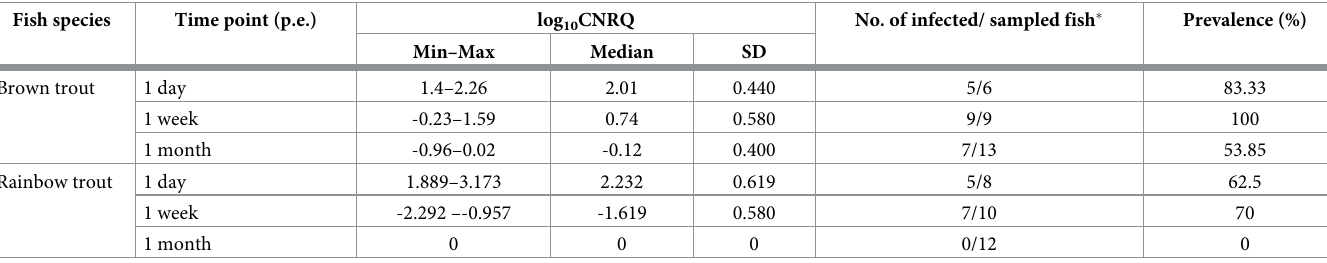
Table 2. Descriptive statistics of Myxoboluscerebralis infection in the blood of salmonids. Fish species Time point